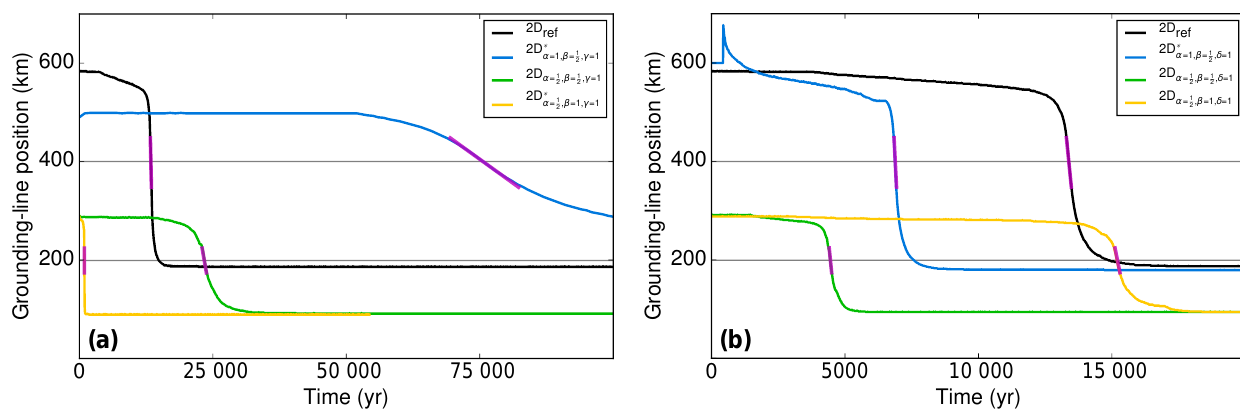
Figure 5. Time series of grounding-line position for the reference and three geometrically scaled flow-line experiments with (a) identical basal friction and (b) identical surface mass balance, respectively. Grey horizontal lines indicate location of the minimum of the bed depres- sion for both the scaled and unscaled case. In the range of ± 50km around the minimum depression, the slope of the curve of the unscaled simulation is fitted to obtain a reference retreat rate of 0.54 km/yr (purple slope fitted to black curve). This slope is used to predict the slopes, i.e., retreat rates, for the scaled experiments (other curves overlaid by purple lines with predicted slopes) according to Table 1.